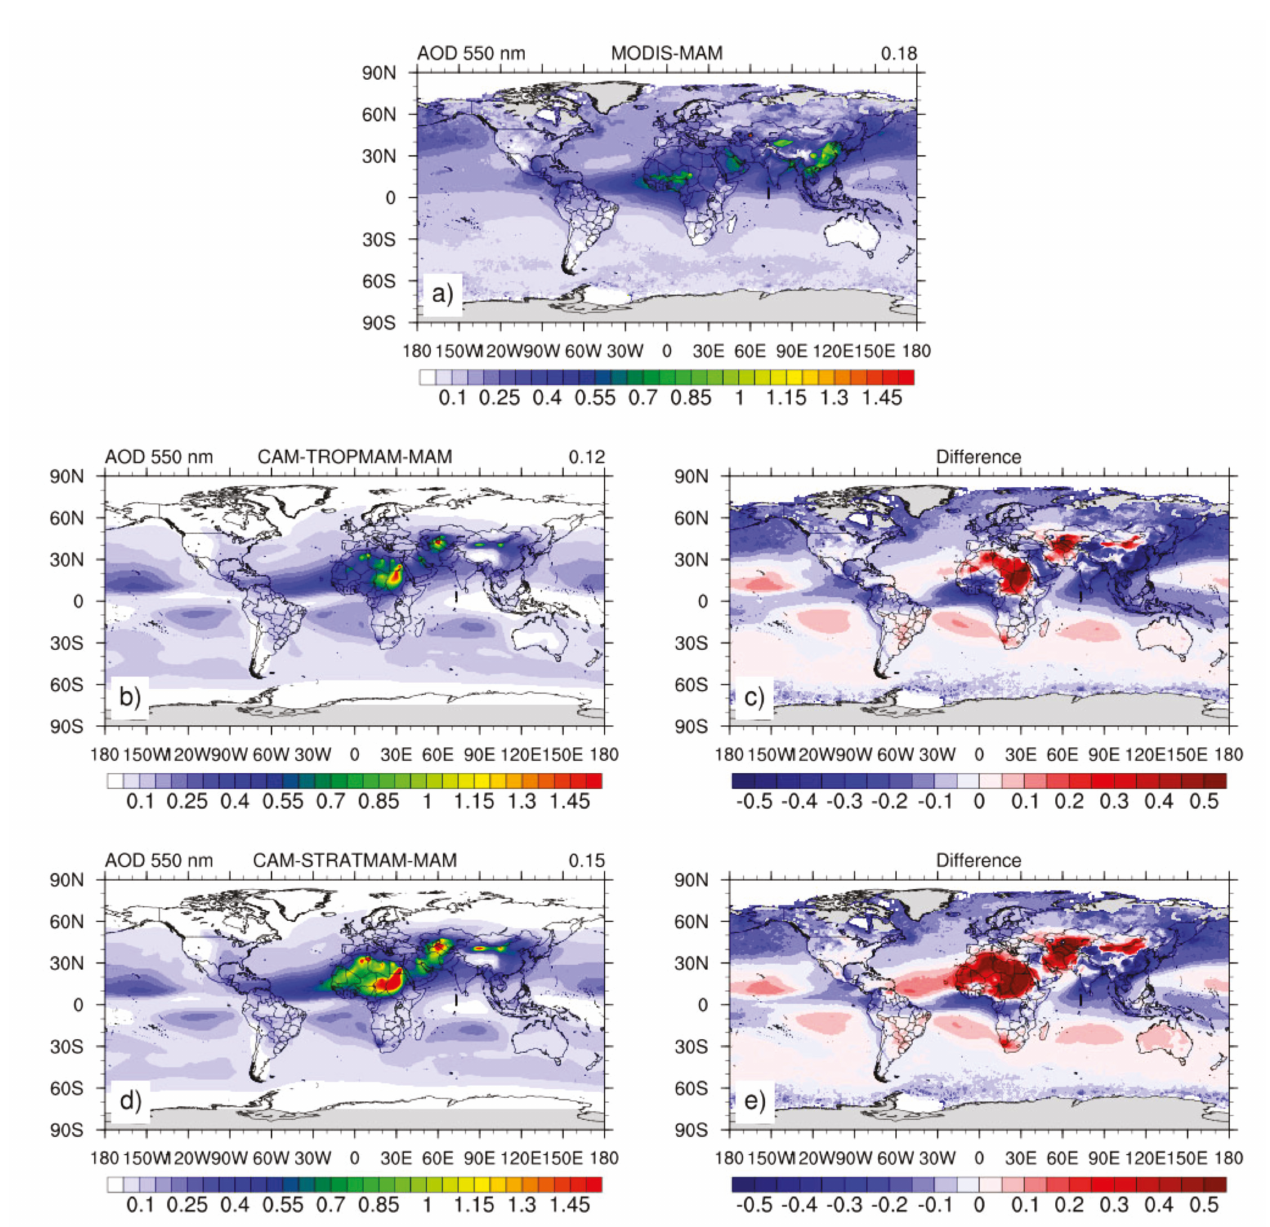
Figure 7. ( a ) AOD observed by MODIS sensor for March-April-May (MAM), in the period of 2010–2014, ( b ) AOD simulated by the CAM5-MAM3 model using tropospheric chemistry and ( d ) tropospheric/stratospheric chemistry mechanisms. The right side of the figure shows the model difference minus the observation (MODIS), ( c ) for tropospheric chemistry and ( e ) for tropospheric/stratospheric